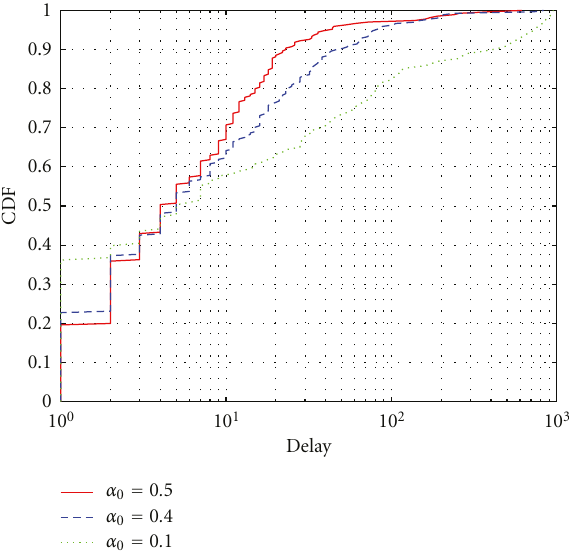
Figure 9: Average performance gains over the random Q values versus di ff erent γ and α when system state is fully observable.